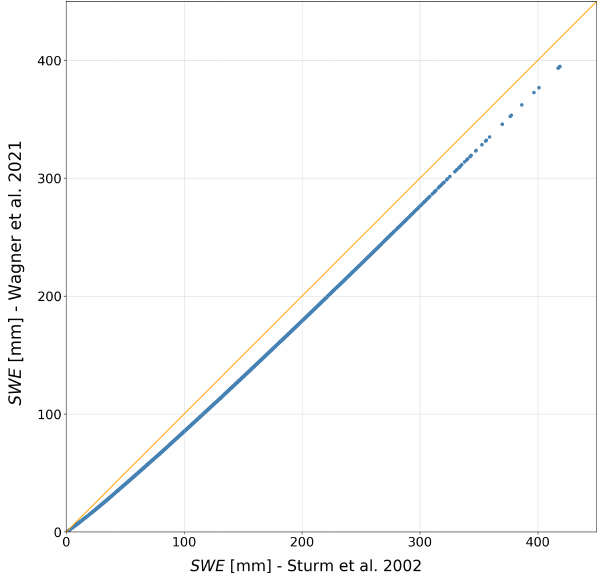
Figure A1. Scatter plot of derived SWE after fitted function in this paper and function by Sturm et al. (2002a). The orange line marks where r = 1 .